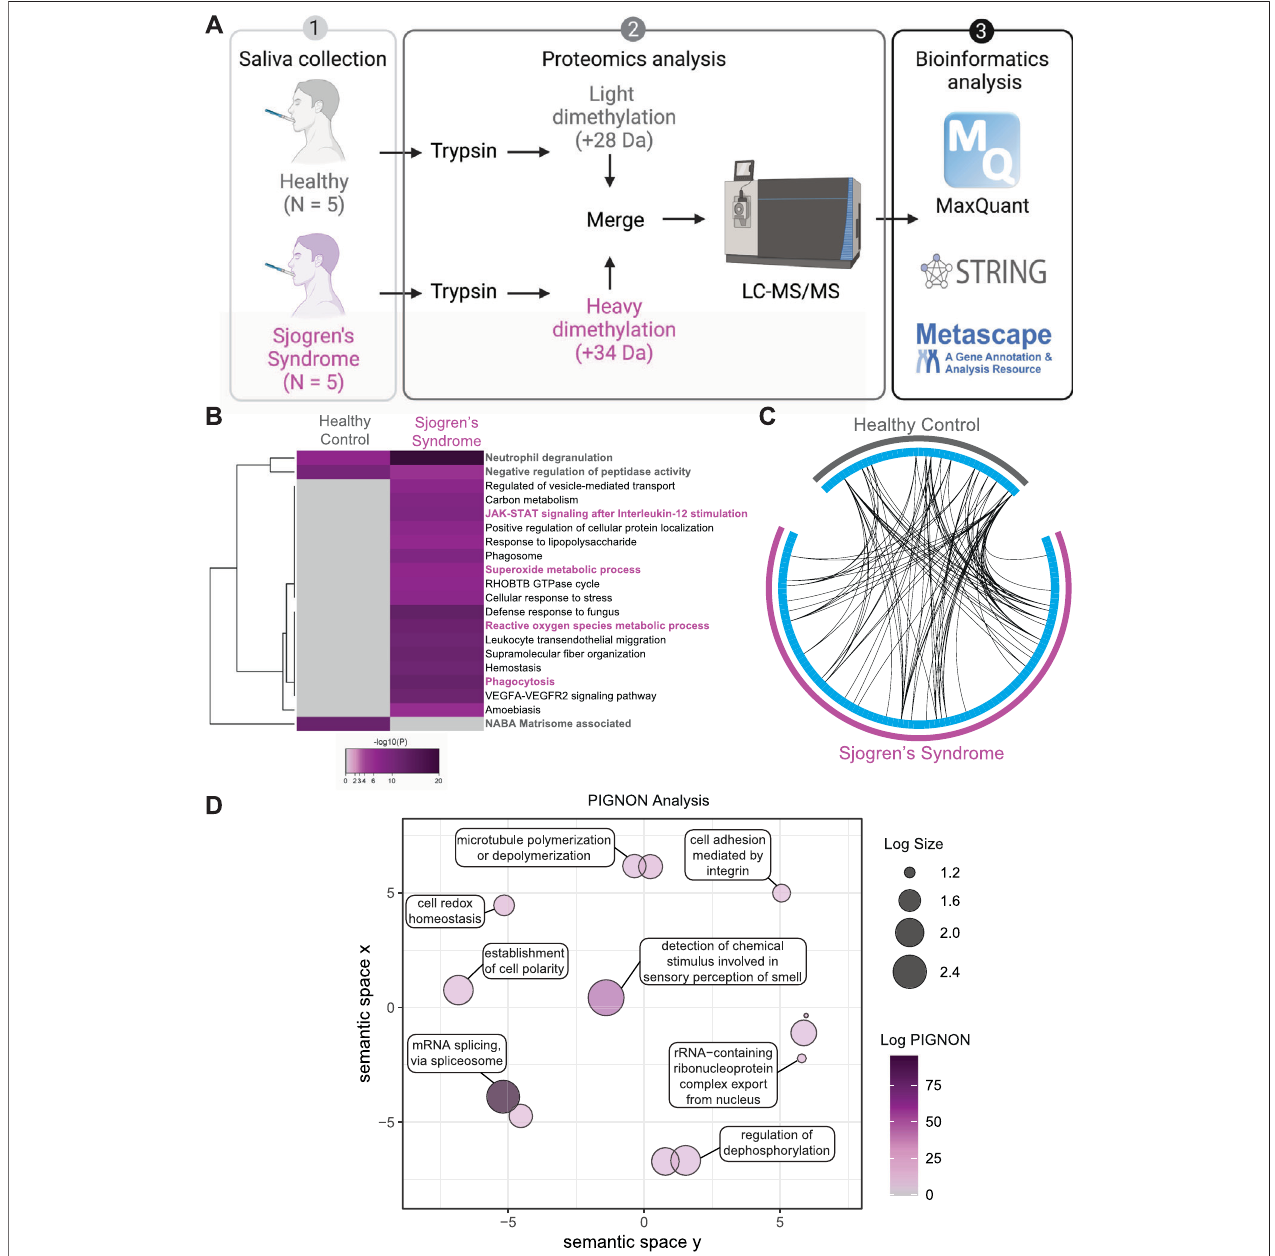
FIGURE 4 | Quantitative Proteomics of Sjogren ’ s Syndrome Saliva. (A) Proteomics work fl ow and analysis (N (cid:2) 5, Sjogren ’ s syndrome (SS) and N (cid:2) 5 healthy controls). STRINGdb and Metascape software were used to identify pathway enrichment and protein-protein interactions. A list of all detected proteins is provided in Supplementary Table S2 . (B) Metascape analysis of different pathways between SS and healthy control saliva samples. Magenta marked are upregulated in SS and grey marked are upregulated pathways in healthy controls. Accumulative hypergeometric p -values and enrichment factors were calculated and used for fi ltering. Remainingsigni fi canttermswerethenhierarchicallyclusteredintoatreebasedonKappa-statisticalsimilaritiesamongtheirgenesmemberships. Then,0.3kappascore was applied as the threshold to cast the tree into term clusters. (C) Circos plot shows how signi fi cant proteins from the input lists overlap and were generated with Metascape. On the outside, each arc represents the identity ofeach gene list (Sjogren ’ s syndrome in magenta and Healthy control in grey). On the inside, each cyan arc representsagenelist,whereeachgenehasaspotonthearc.Blacklineslinkthedifferentgeneswheretheyfallintothesameontologyterm. (D) VisualizationofPIGNON resultsusingRevigo.Thex-and y -axishavenointrinsicmeaning.Intheplot,semanticallysimilarGOtermsremainclosetogether.LogSizeequalstotheLog 10 (Numberor annotations for GO Term ID in Homo sapiens in the EBI GOA database). Log PIGNON equals to the -Log 10 (FDR-adjusted p value as generated by PIGNON). The PIGNON analysis was performed using the normalized protein ratios as calculated by Maxquant. PIGNON was set to use the “ physical link ” network (v11) from the STRING database due to the small size of our dataset. The results included mapped pathways that were trimmed according to a false discovery rate (FDR) of 1%. The lists of enriched gene ontology (GO) terms, along with the p -values, were submitted to Revigo to summarize the biological functions and provide visualization of enriched terms.